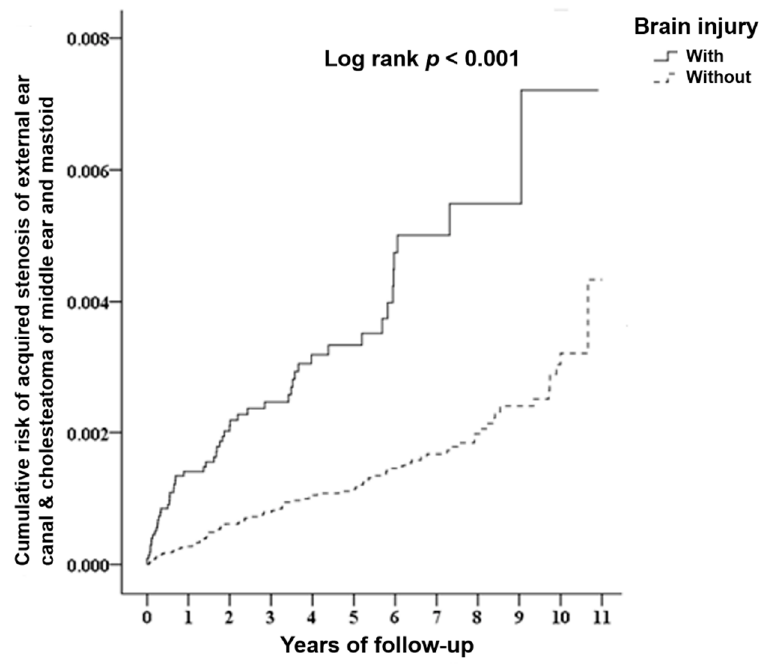
Figure 2. Kaplan–Meier curve of the cumulative risk of events (acquired stenosis of the external ear canal and cholesteatoma of the middle ear and mastoid) stratified by brain injury with the log-rank